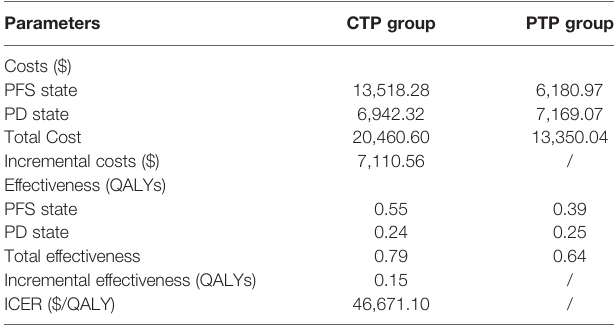
TABLE 3 | The cost and outcome results of the cost-effectiveness analysis. Parameters